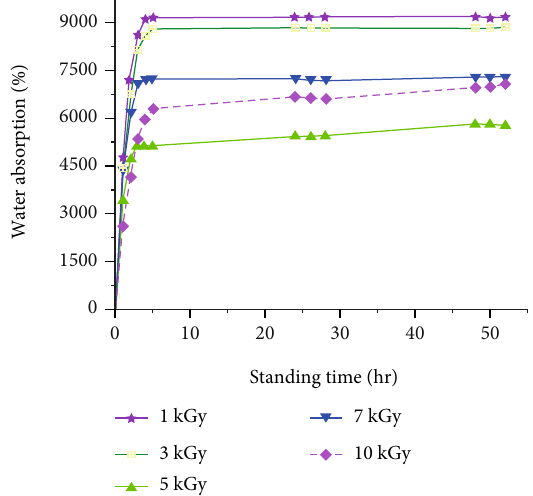
Figure 7: E ff ect of radiation dose and standing time on water absorption of THG.